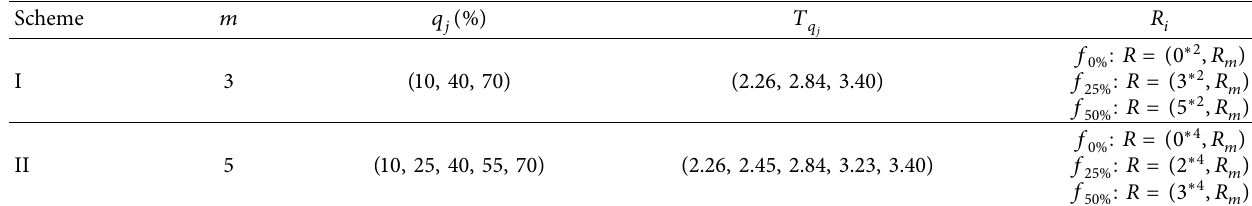
Table 9: Removal patterns of units under different censoring schemes for data set II. Scheme